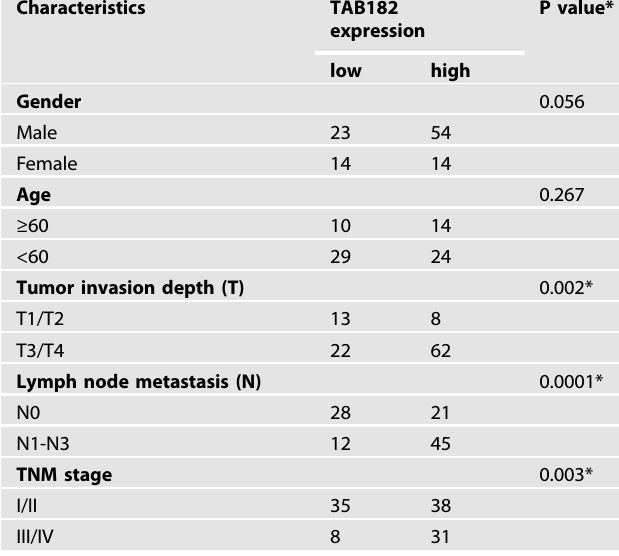
Table 1. The correlation between TAB182 expression and ESCC patients ’ pathological features.